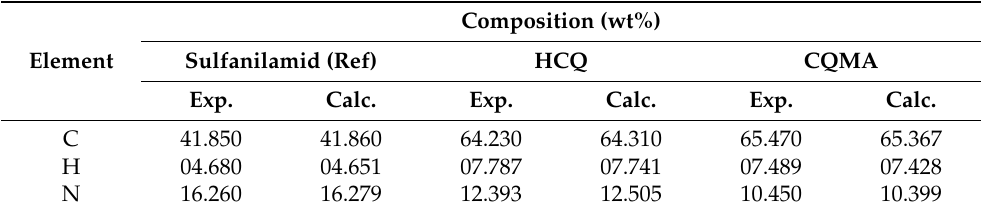
Table 3. Comparison between the experimental determination of the elementary composition of the CQMA and that calculated.